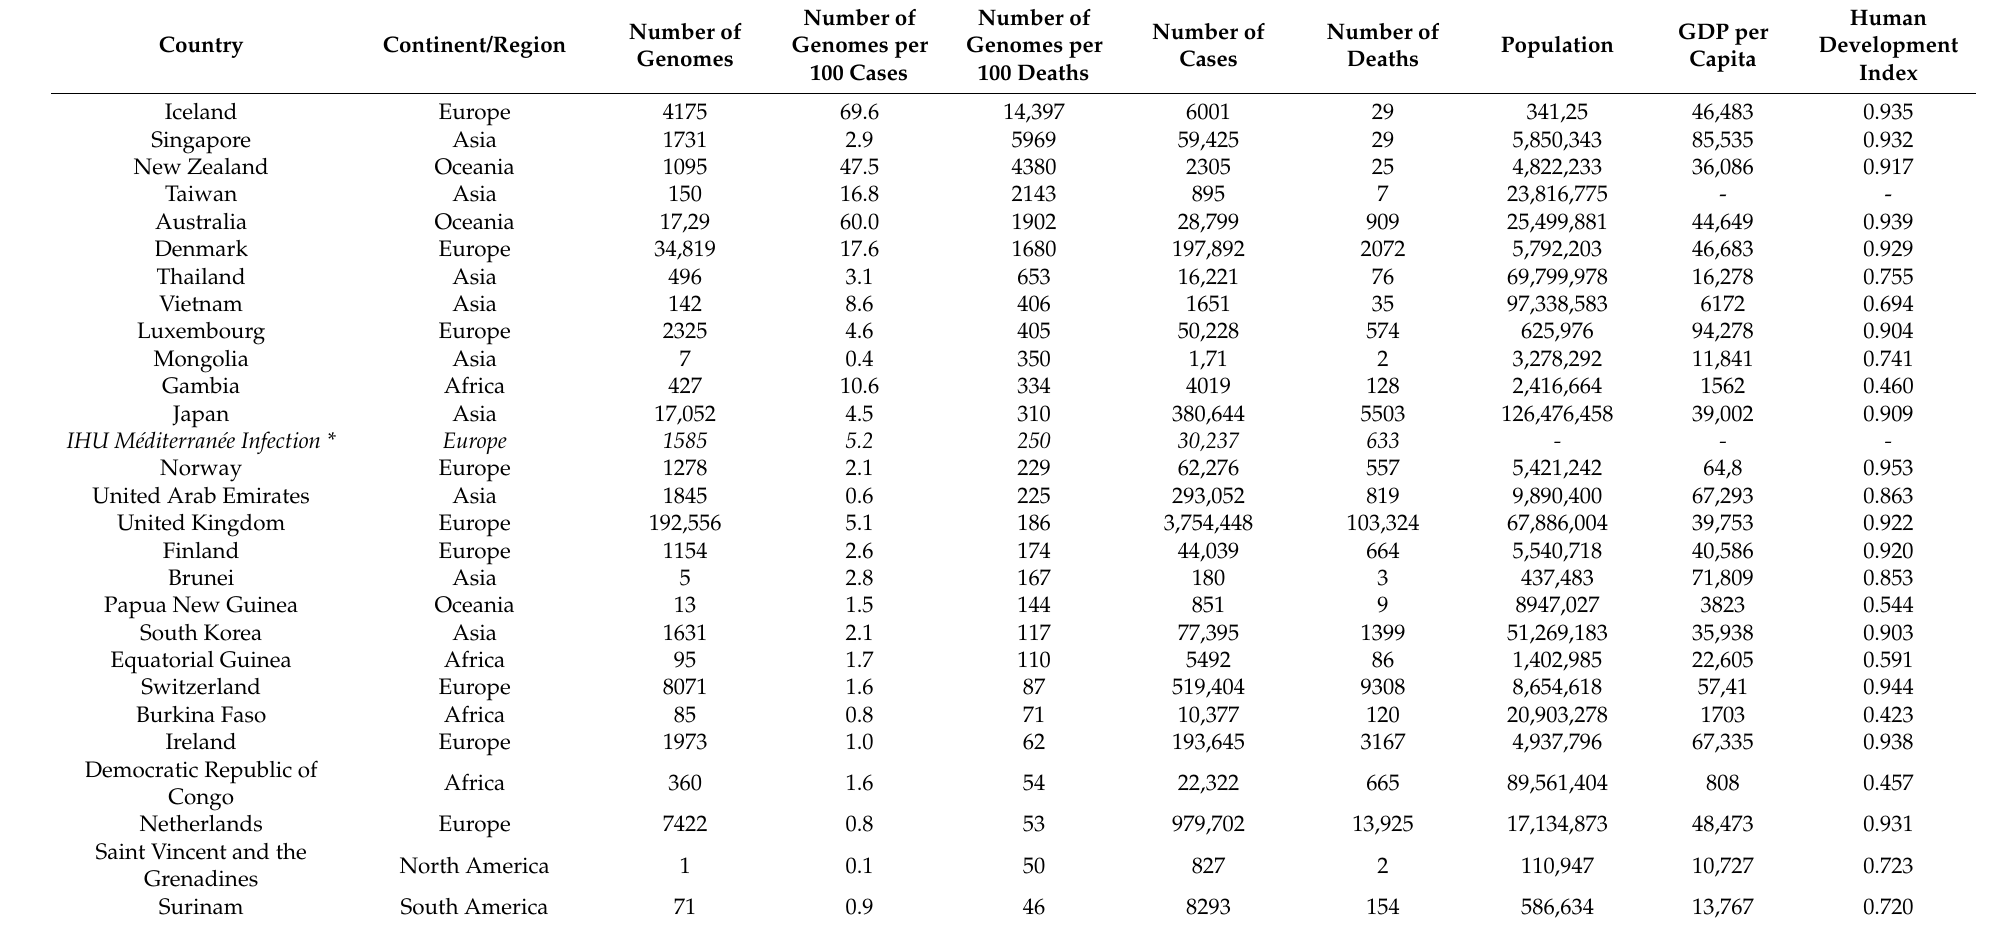
Table 1. Number of genomes, of SARS-CoV-2-diagnosed cases, of SARS-CoV-2-associated deaths per country, and various epidemiological data among which population size, life expectancy, gross domestic product (GDP) per capita, or human development